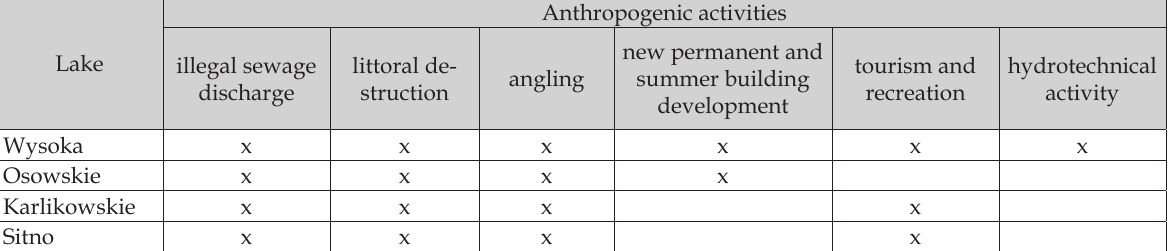
Table 6. Identification of anthropogenic activities for lakes most endangered with degradation